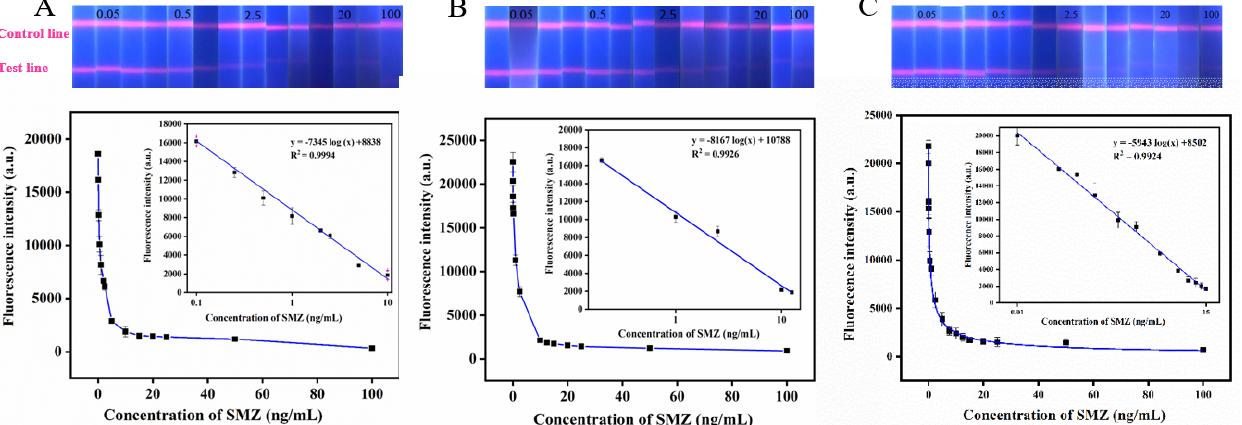
Figure 8. The digital photos under UV light of the QBs-LFIA test strips and corresponding standard calibration curves for SMZ were constructed by plotting the fluorescence intensity against the logarithm of different concentrations of SMZ in ( A ) PBS, ( B ) chicken, and ( C ) milk samples. Table 1. Comparison of the linear range, LOD, and specificity of this method and others.